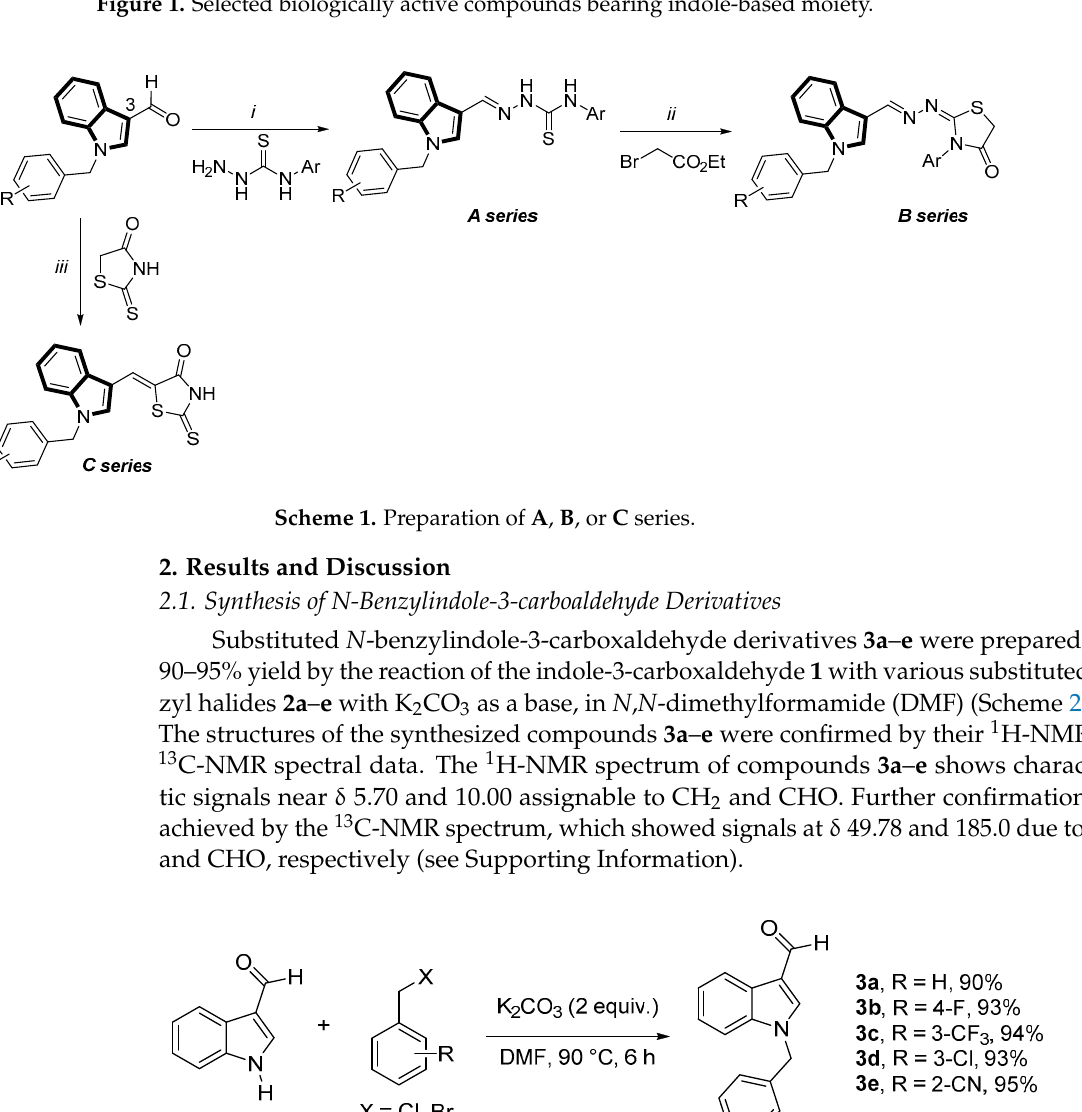
Figure 1. Selected biologically active compounds bearing indole-based moiety.